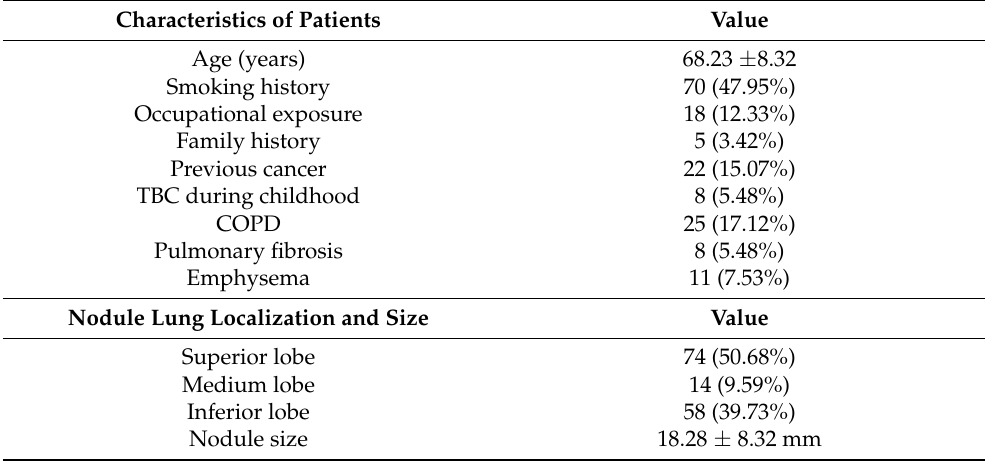
Table 1. Demographic data and clinical characteristics of the study